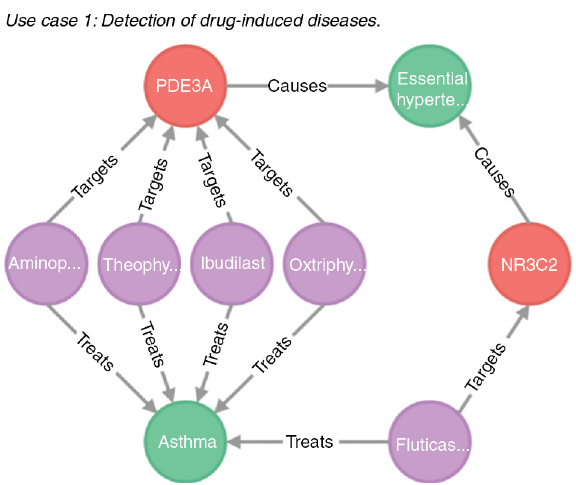
Figure 3: Network analysis of drug-induced diseases. The web interface represents the database entities (diseases, drugs, and proteins) as nodes in a network with edges representing the relationships between them. As illustrated in Figure 3, the network shows drugs (violet) which are prescribed for the treatment of the comorbid diseases (green) but also target genes (red) which may cause the diseases. For instance, the anti-asthmatic drug “ Ibudilast ” may induce hypertension by targeting the gene PDE3A. As a consequence, these drugs have to be avoided in order to reduce the risk of induced diseases.